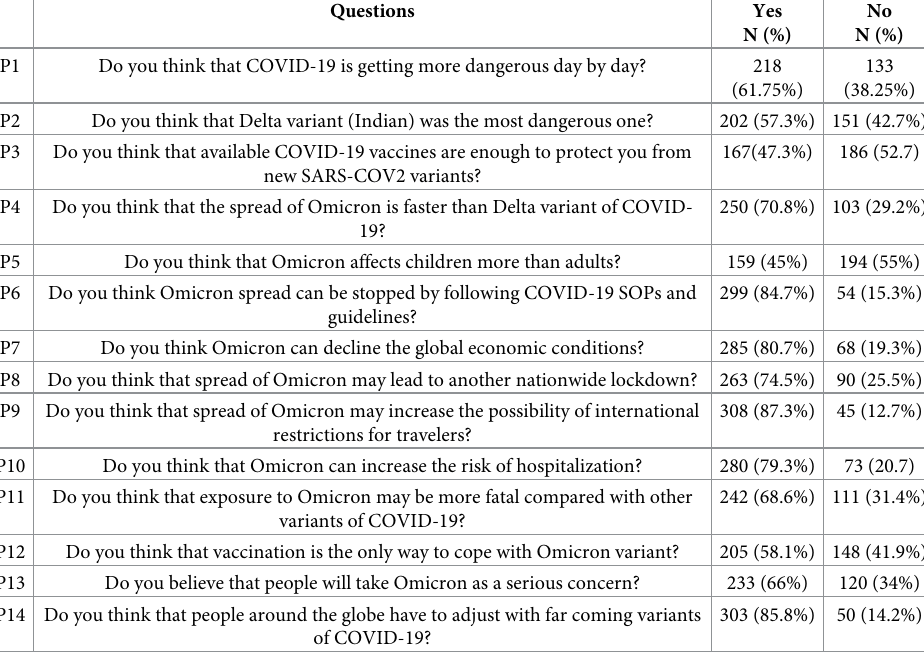
Table 6. Respondents’ perception regarding COVID-19 and its